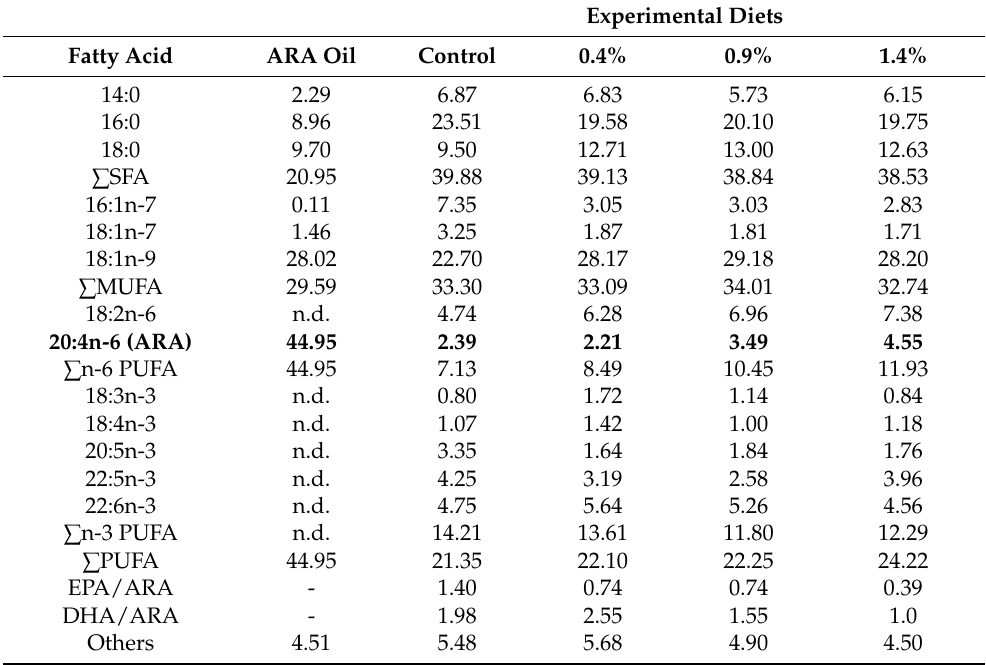
Table 2. Fatty acid composition of the experimental diets and oils (% total fatty